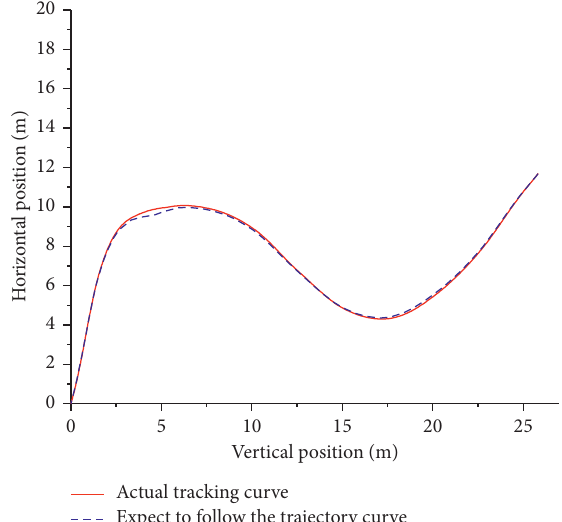
Figure 22: Trajectory position tracking comparison